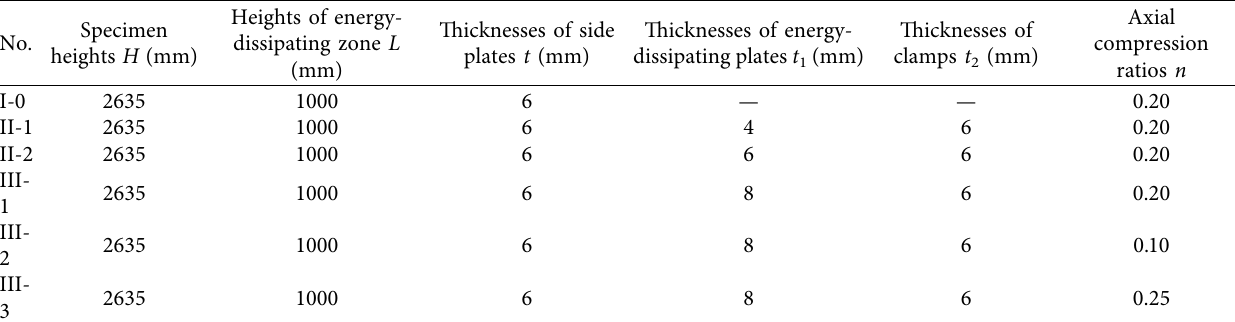
Figure 2: Details of the new box-shaped steel pier/mm. (a) Elevation. (b) Cross section of group I (c) Cross section of group II, III. Table 1: Critical parameters of test